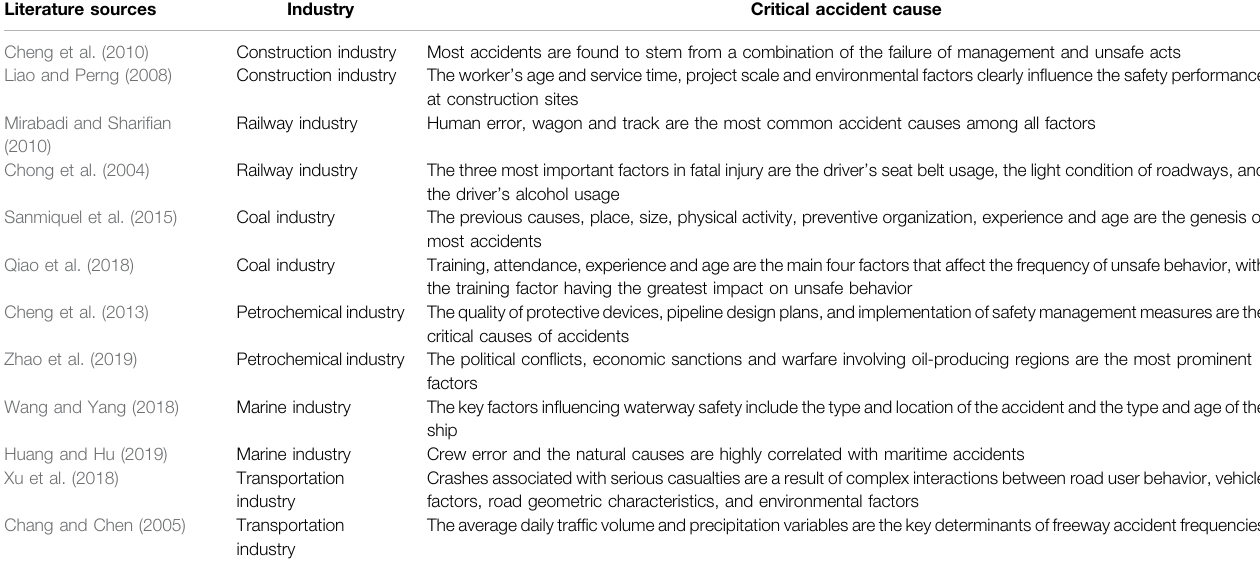
TABLE 1 | Literature review of accident cause analysis using data mining